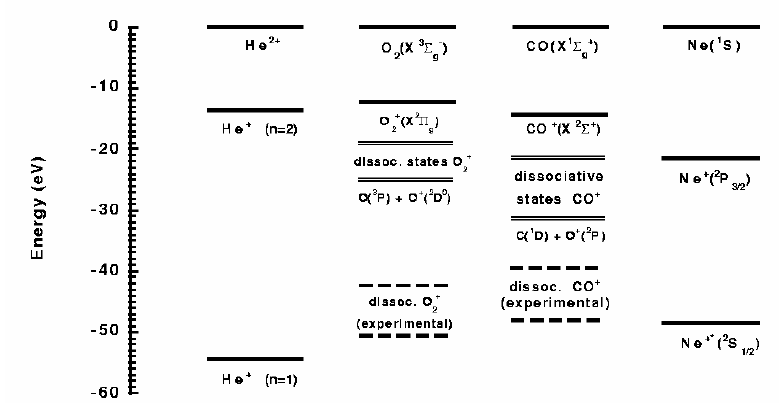
Fig. 6 : Energy level diagram for SEC in collisions of He 2+ with Ne, O